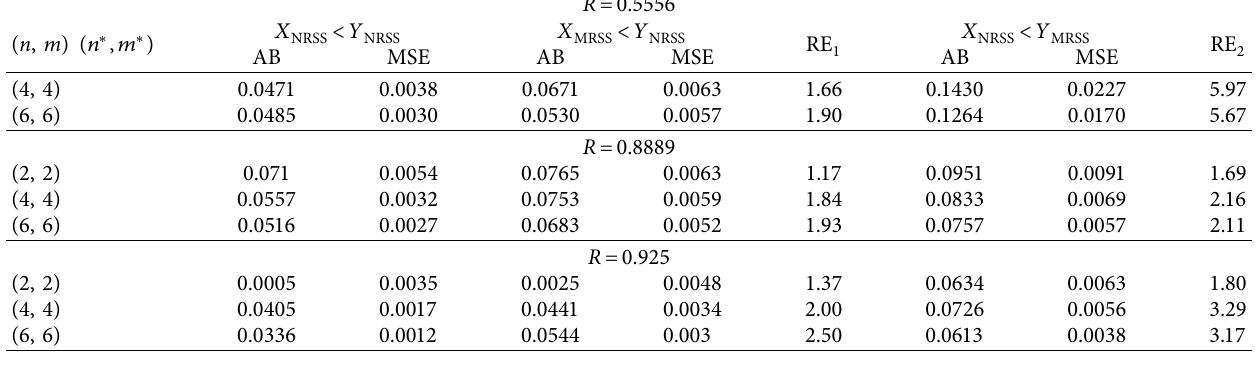
Table 5: Some measures of SSR estimates based on MRSSE and NRSS. R � 0.5556